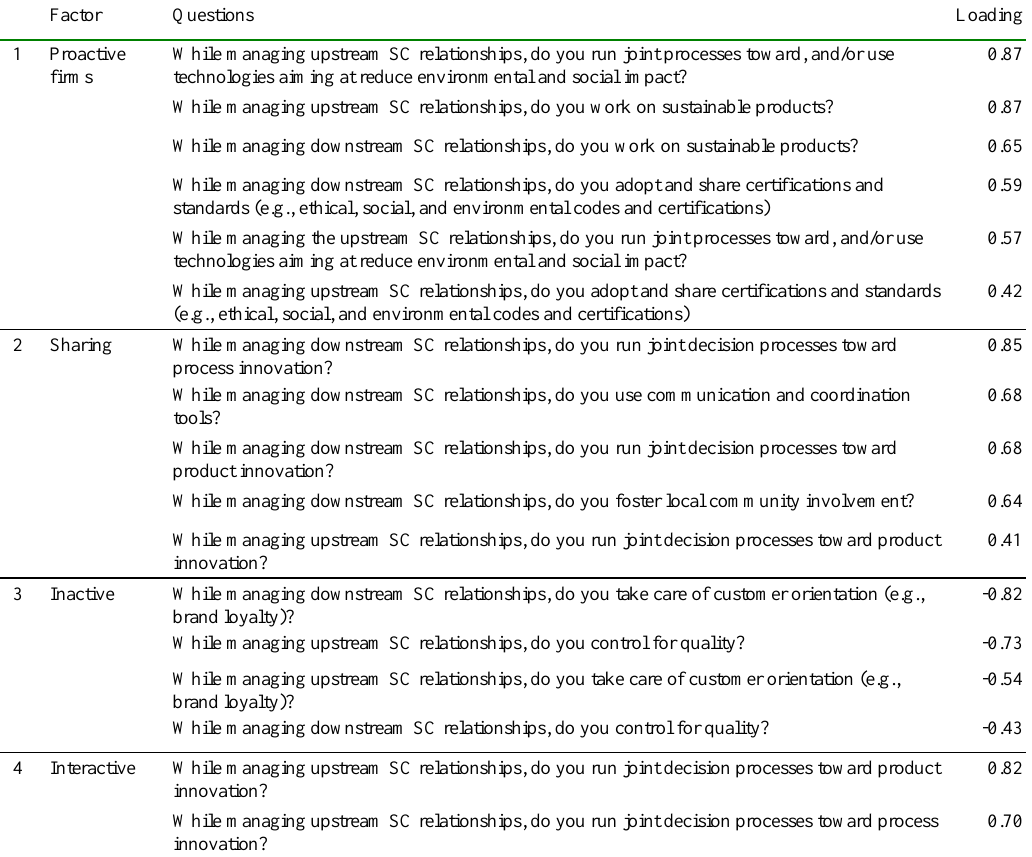
Table 2 : Factors Characterizing SSCM Relationships Factor Questions Loading 1 Proactive